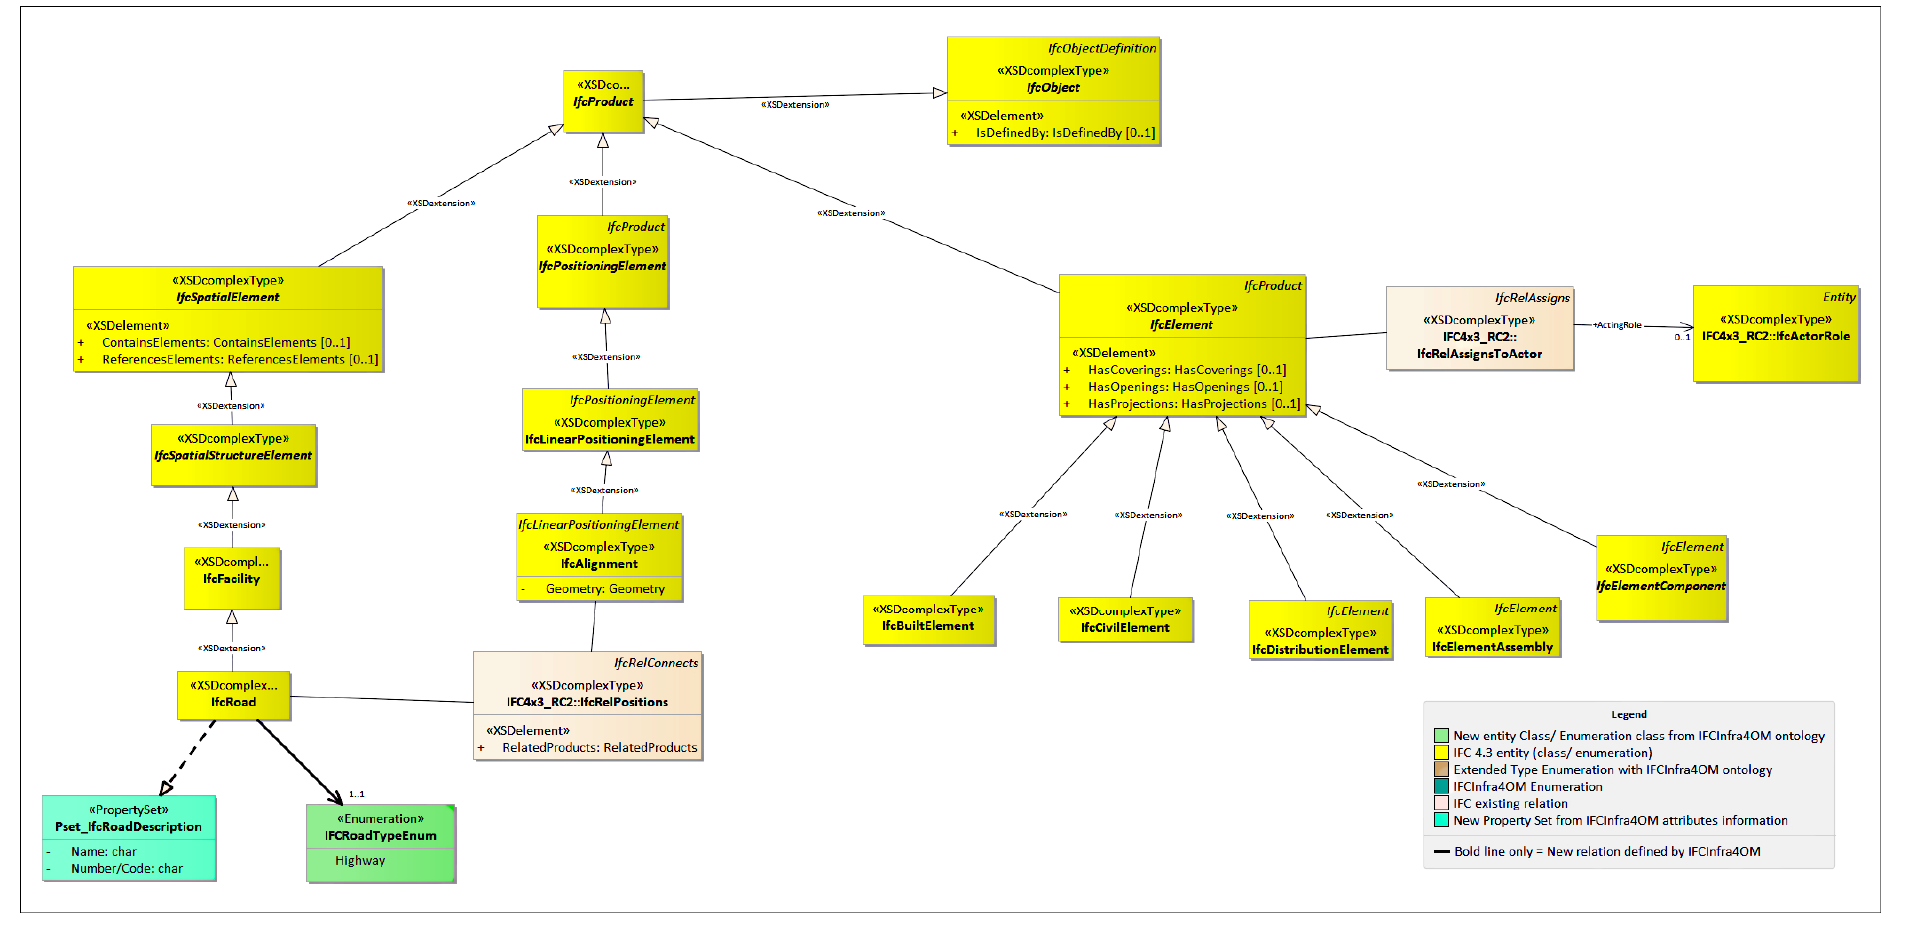
Figure 4. IFC extension by IFCInfra4OM UML data model: ( a ) “Operation” package; ( b ) “Monitoring” package; ( c ) “Actors” package; ( d ) “Road Component” package.